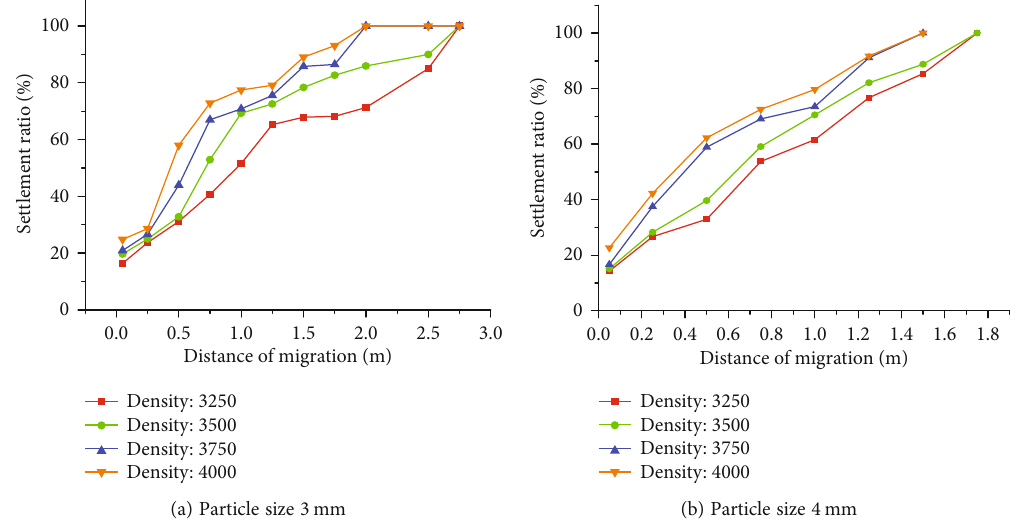
Figure 10: Variation of settlement ratio of aggregates with their fl ow distance at di ff erent particle